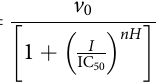
species fraction (Fig. 2e) to Eq. (1): F ¼ F 0 þ A e (cid:2) kt ð 1 Þ